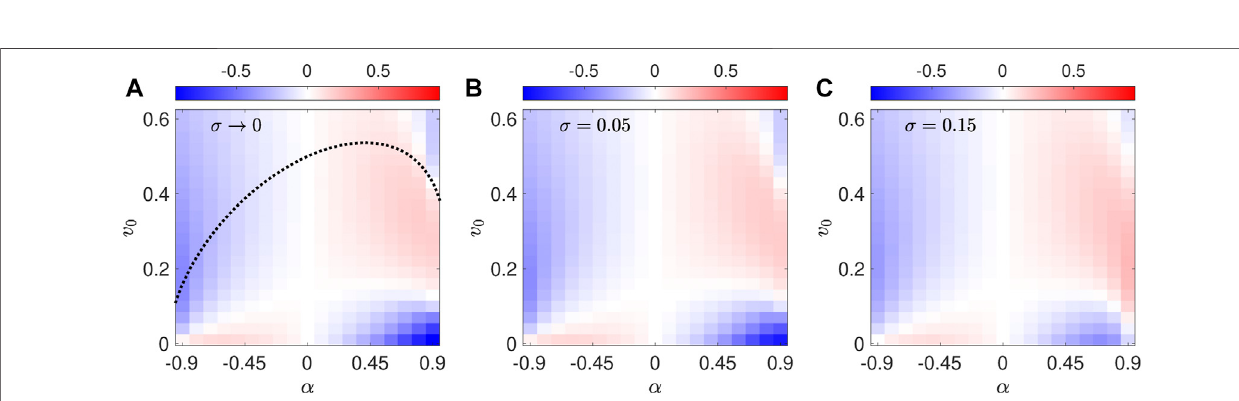
FIGURE 11 | Phase space weight factors g for (A) α (cid:1) − 0.7 and (B) α (cid:1) 0.9. The solid curves are g ( Ψ ), and the dotted curves represent the separatrices at ± Ψ s . Different shades represent different swimming speeds v 0 . (A) Black is v 0 (cid:1) 0.02, and grey is v 0 (cid:1) 0.6. (B) Black is v 0 (cid:1) 0.02, and grey is v 0 (cid:1) 0.8.